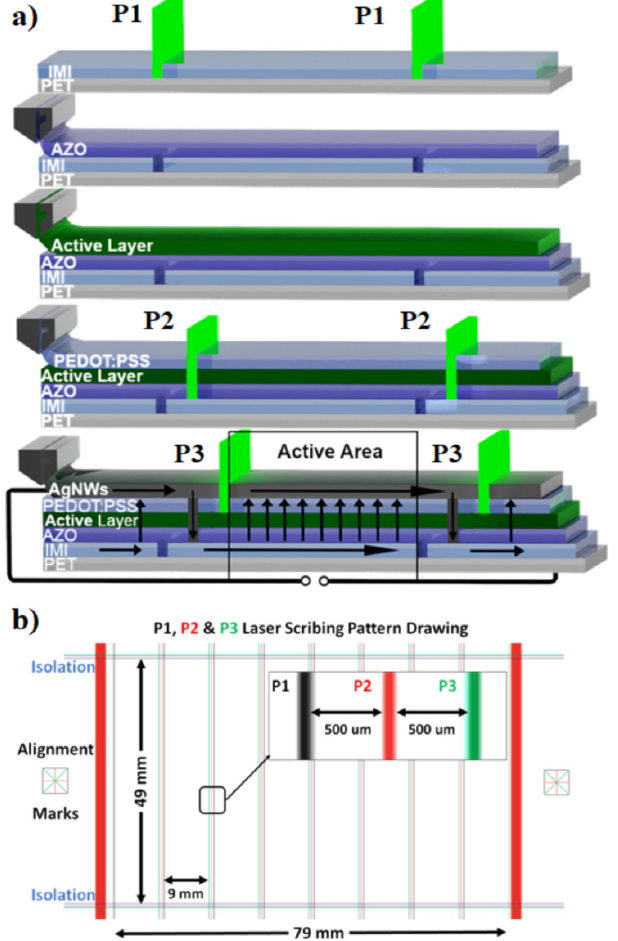
Figure 1. ( a ) Schematic of OPV device structure with P1, P2 and P3 scribes and ( b ) laser scribing pattern used for the manufacturing of OPV modules.